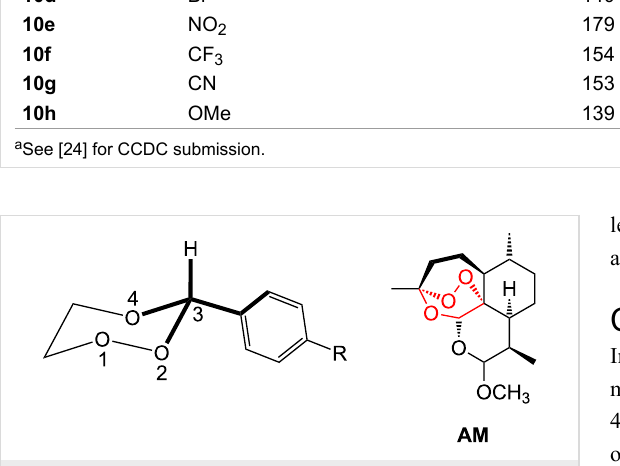
Figure 5: Numbering of 3-aryl-1,2,4-trioxanes 10 and relevant bonds; structure of artemether ( AM ).